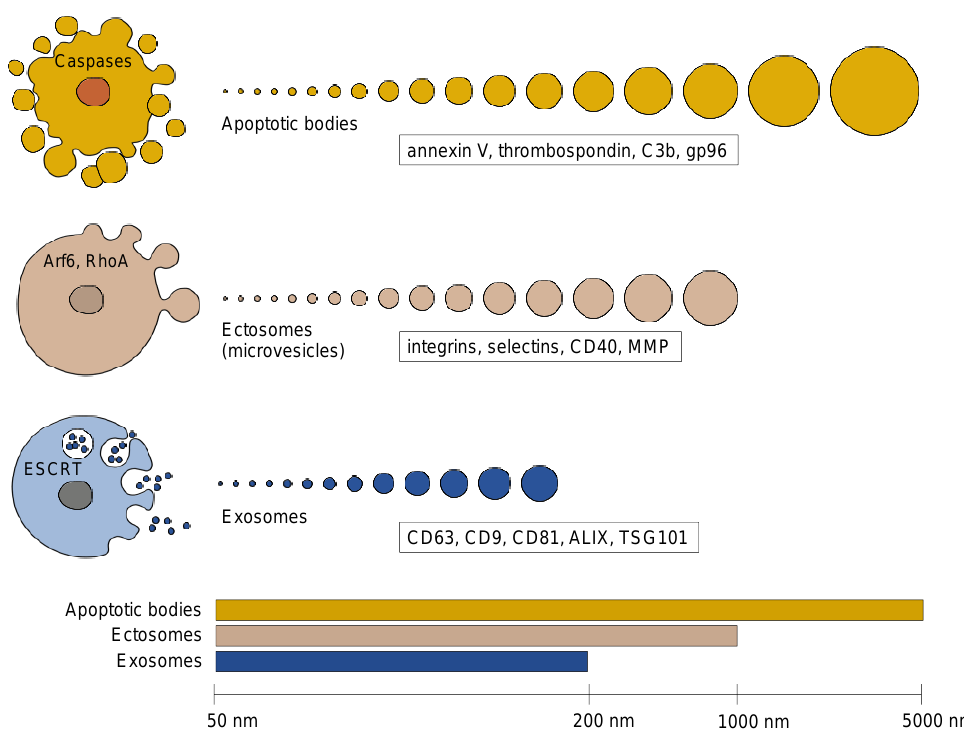
Figure 1. Extracellular vesicle diversity. Traditionally, EVs are classified into three major categories consisting of apoptotic bodies, ectosomes (microvesicles) and exosomes. Proteins indicated in rectangular boxes are referring to commonly used markers for the corresponding EVs.